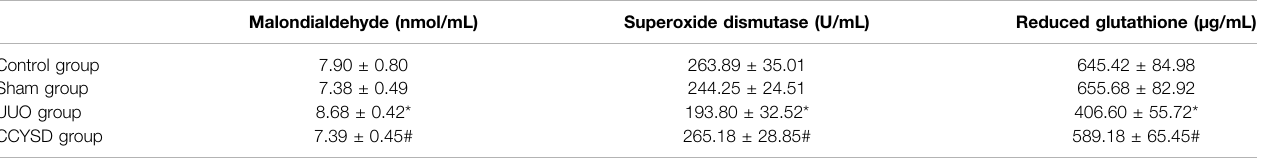
TABLE 1 | Serum oxidative stress levels of rats in each group ( (cid:1) X ± S ). Malondialdehyde (nmol/mL) Superoxide dismutase